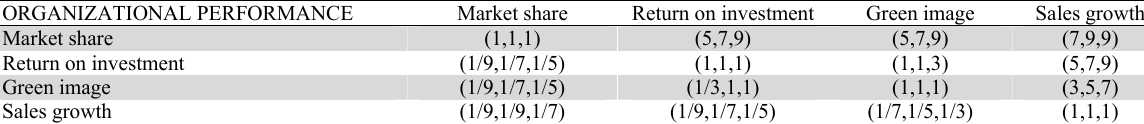
Fuzzy pair-wise comparison of Organizational performance Enablers ORGANIZATIONAL PERFORMANCE